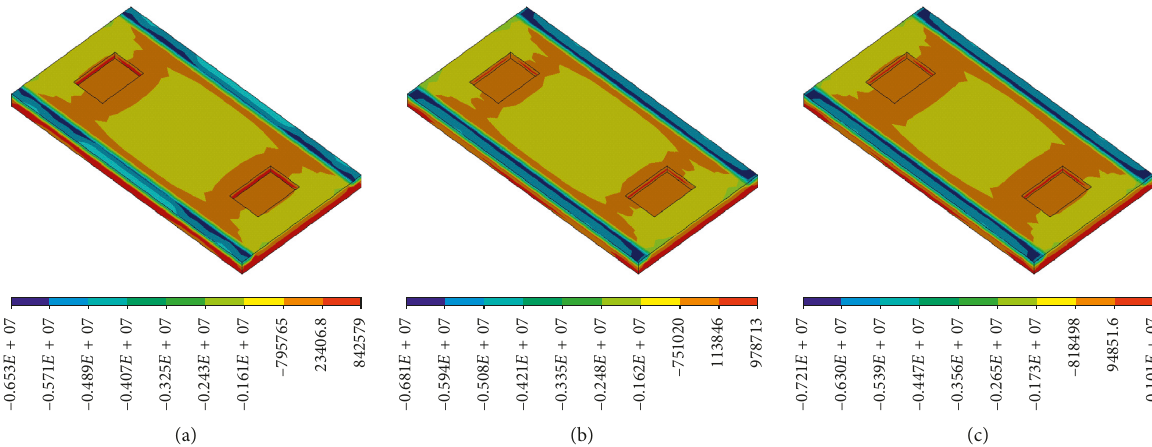
Figure 18: Longitudinal stress of the bed plate under condition 1. (a) P